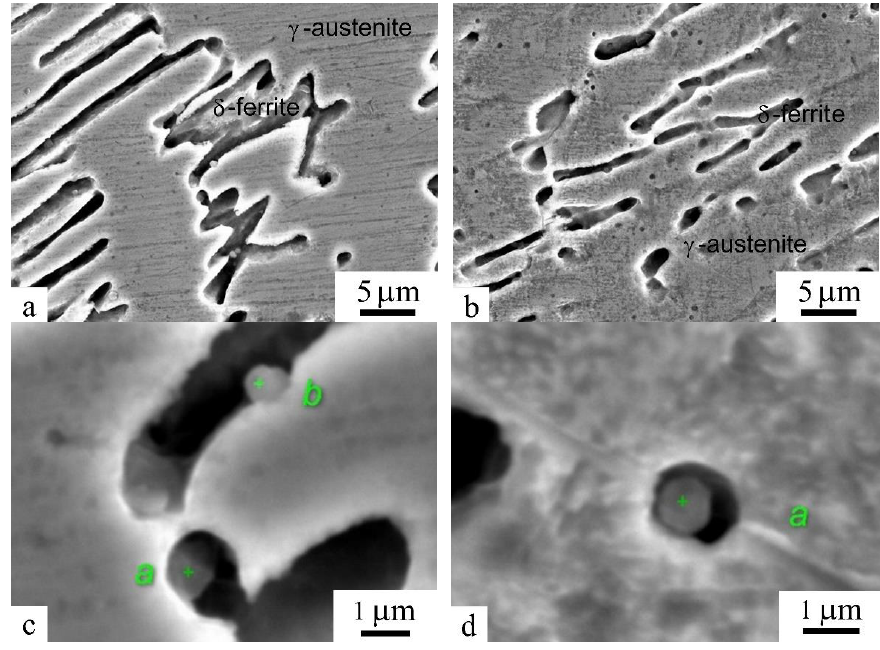
Figure 12. SEM images of the microstructure and carbide particles in the metal deposited without peening ( a , c ) and with peening ( b , d ).